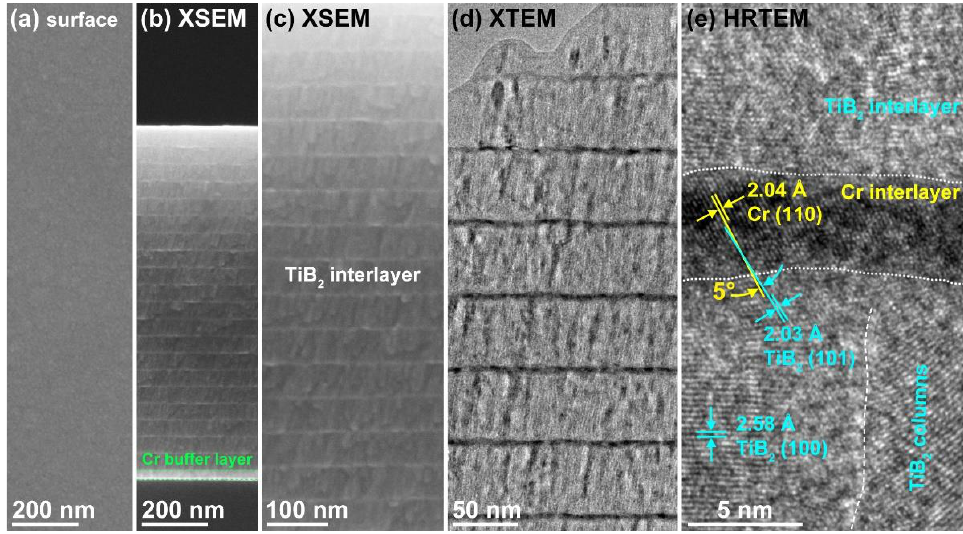
Figure 2. ( a ) SEM surface, ( b , c ) SEM cross-section, ( d ) XTEM, and ( e ) HRTEM images of the TiB 2 /Cr multilayer film.